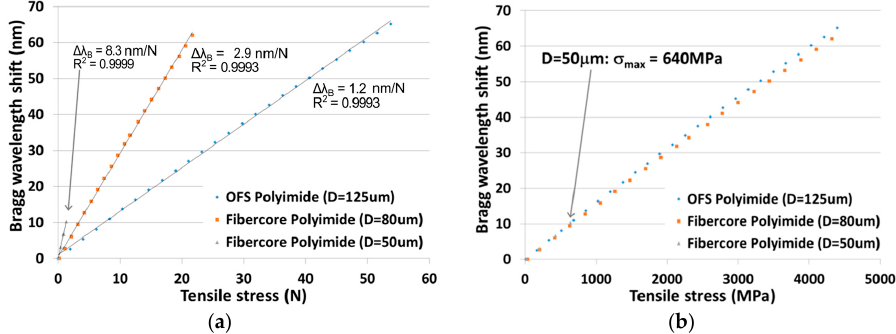
Figure 8. Bragg wavelength shift to tensile stress in: ( a ) N; and ( b ) MPa, for three different-sized polyimide fibers.